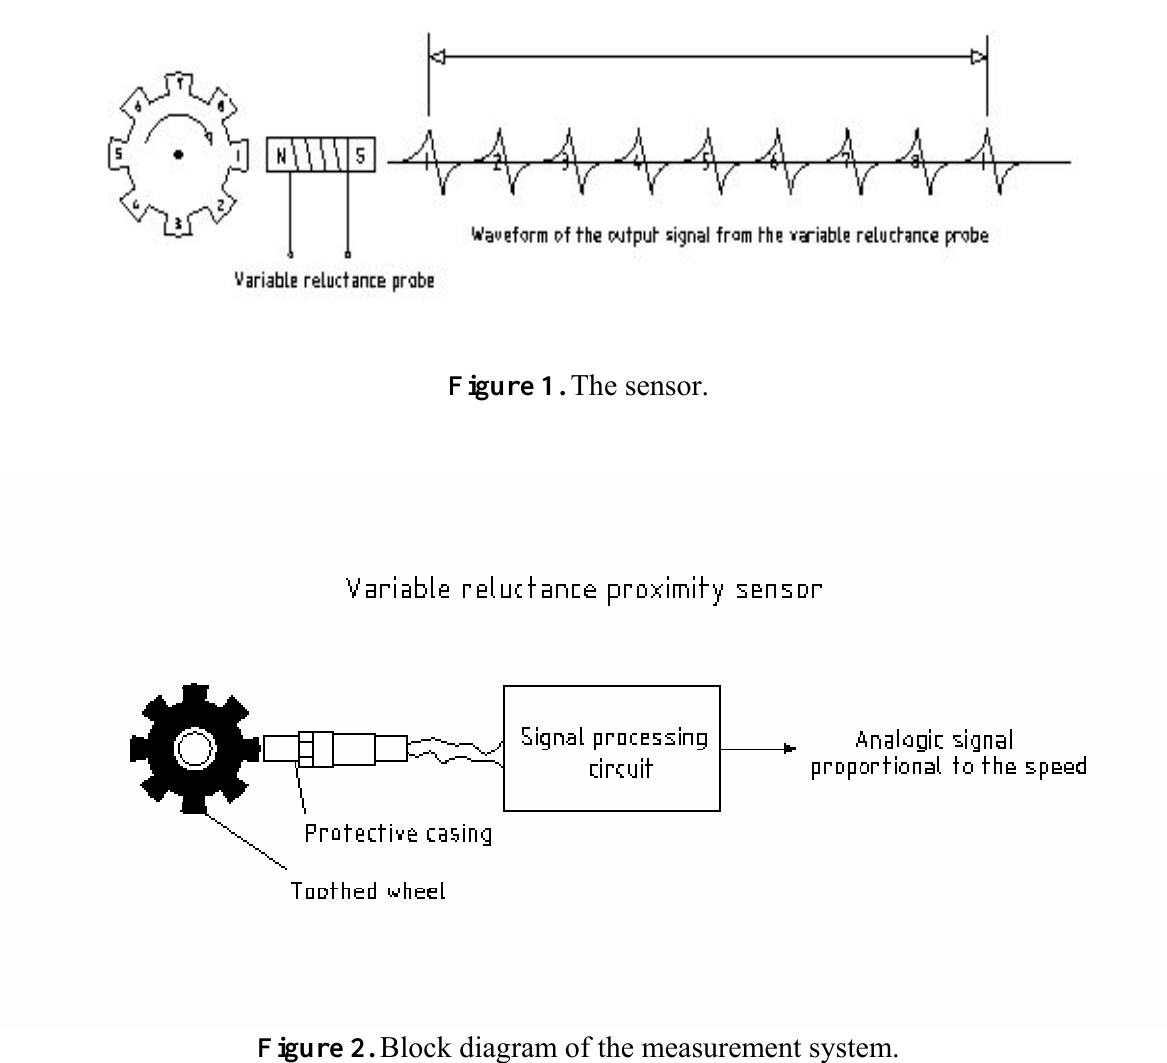
Figure 2. Block diagram of the measurement